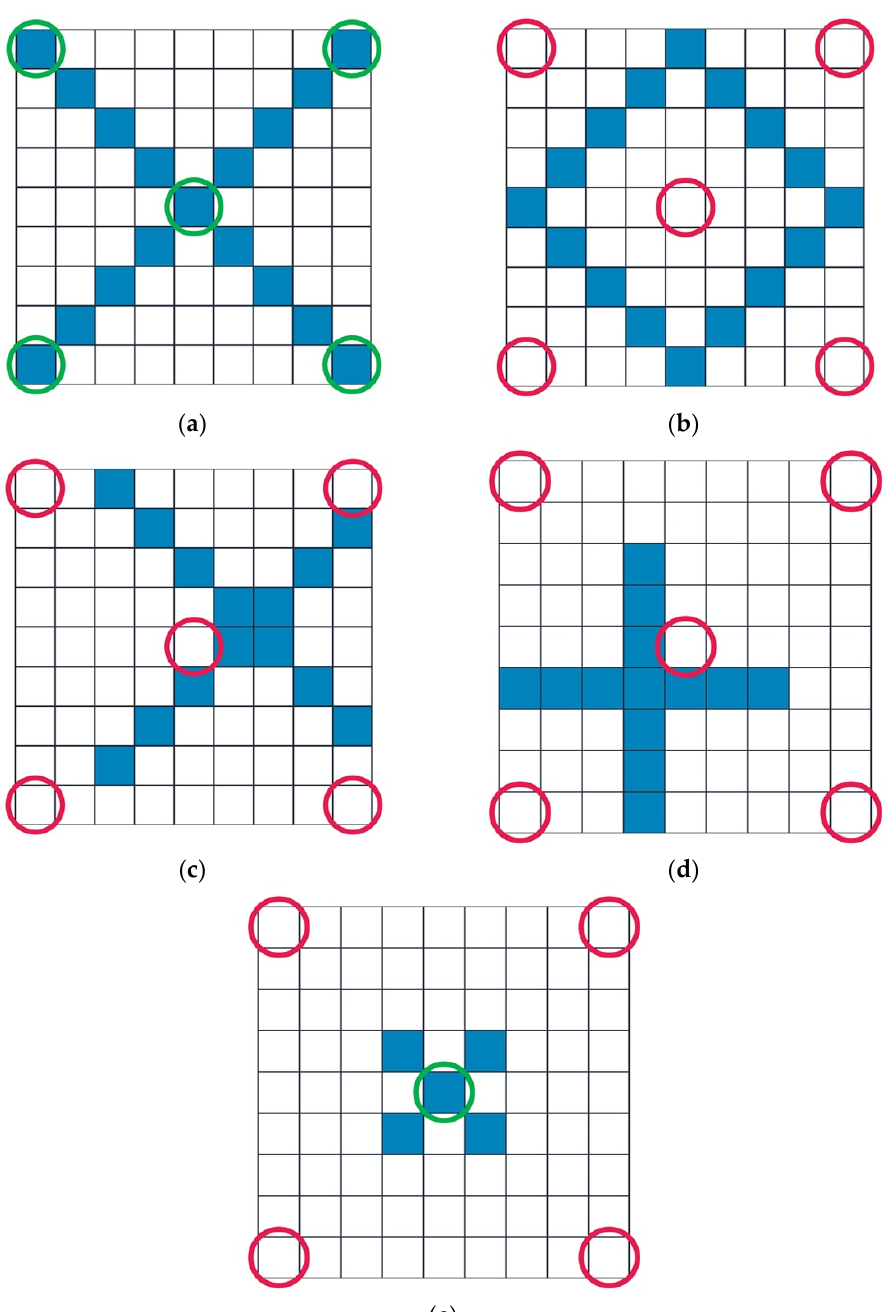
Figure 2. Traditional Programming vs. Machine Learning for Computer Vision (original figures). Squares are representative of pixels comprised of binary graphical indicators for computer recognition, with blue squares comprising a pixelated “input” shape to be recognized by a preset formula that may direct the computer to correctly identifying the shape in its output determination. Green circles are indicative of computer-recognized elements of the pixelated input shape per input programming rules. Red circles represent areas in which programming rules neglected to recognize blue input image elements. Computer programmed rules for defining shapes in figures ( a ) through ( e ) are (1) shape is “X” if the center and corner pixels are full and “O” if the center and corner pixels are empty: ( a ) Pathologist/human interpretation of image: shape is “X”. Computer interpretation of image: shape is “X”, as dictated by rule. Outcome: concordant with pathologist visual interpretation; ( b ) Pathologist interpretation of image: shape is “O”. Computer interpretation of image: Shape is “O”, as dictated by rule. Outcome: concordant with pathologist visual interpretation; ( c , d ) Pathologist interpretation of image: shape is “X”. Computer interpretation of images: shape is “O”,